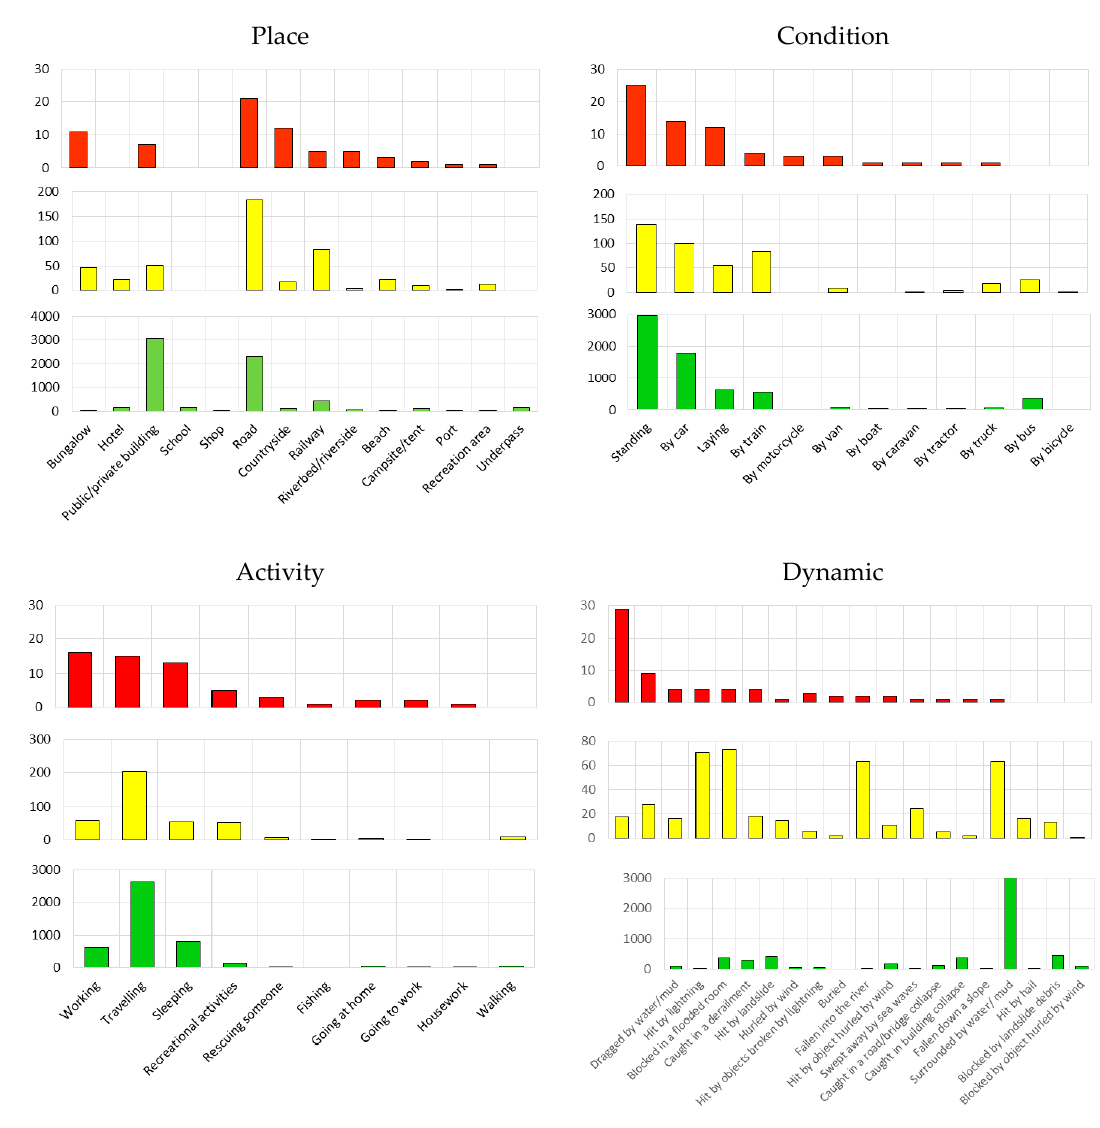
Figure 6. Place, condition, activity and dynamic for fatalities ( red ), injured ( yellow ) and involved people ( green ) (See also Appendix A: Table A2).